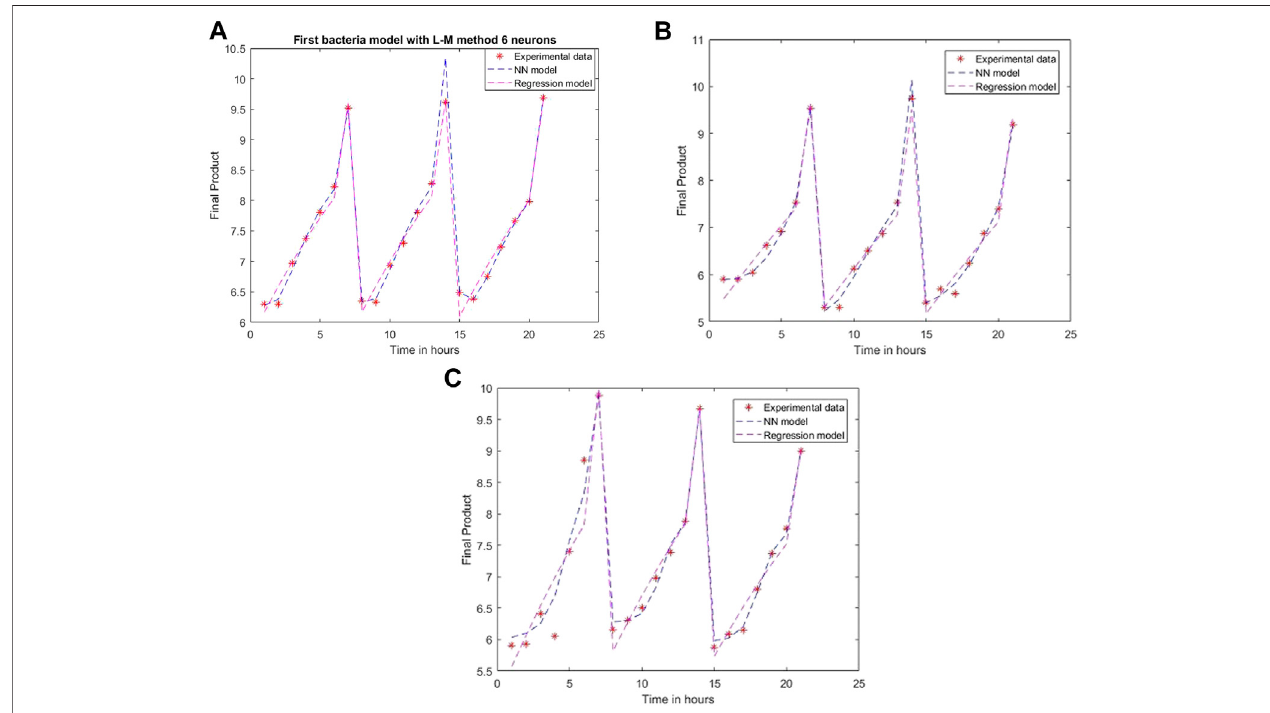
FIGURE 6 | Model results with the Levenberg-Marquardt method and six neurons for (A) L. plantarum ; (B) L. casei ; (C) co-cultures of L. plantarum and L. casei .